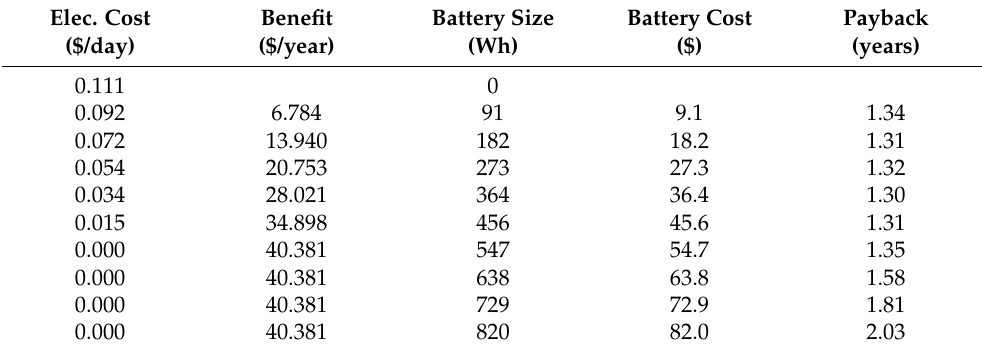
Table 3. Capacity Decision: Refrigerator, TOU, Case 1.